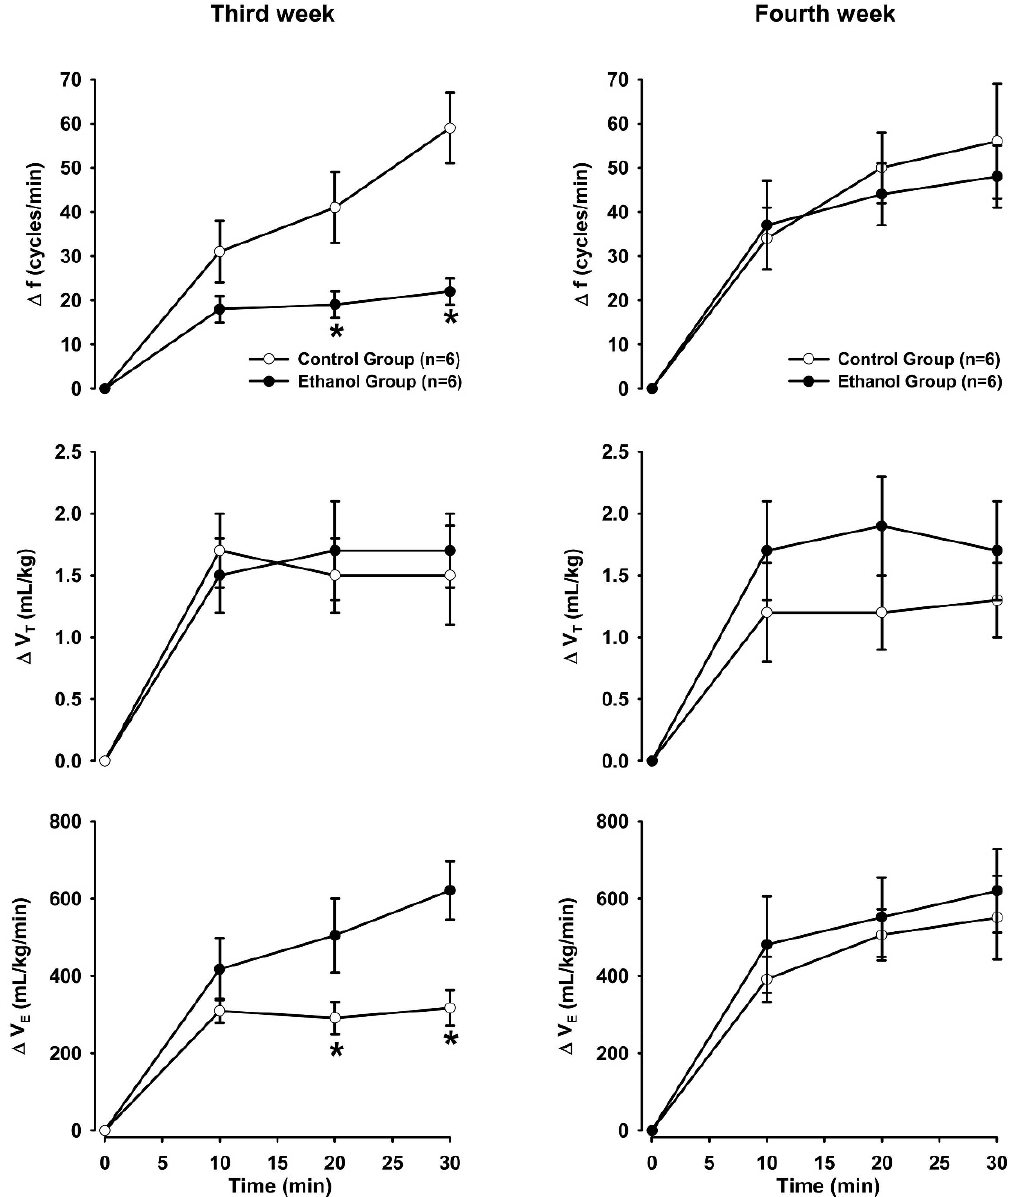
Figure 3 - Changes during the third (left panel) and fourth (right panel) weeks in respiratory frequency (f, top), tidal volume (V T , middle) and minute ventilation (V E , bottom) in response to 10% O 2 -mediated hypoxia in rats receiving water (control group) or ethanol (ETOH) in increasing concentrations (first week: 5% v/v, second week: 10% v/v, third and fourth weeks: 20% v/v). Values are expressed as the mean ¡ SEM. *, p , 0.05 (two-way ANOVA) compared to